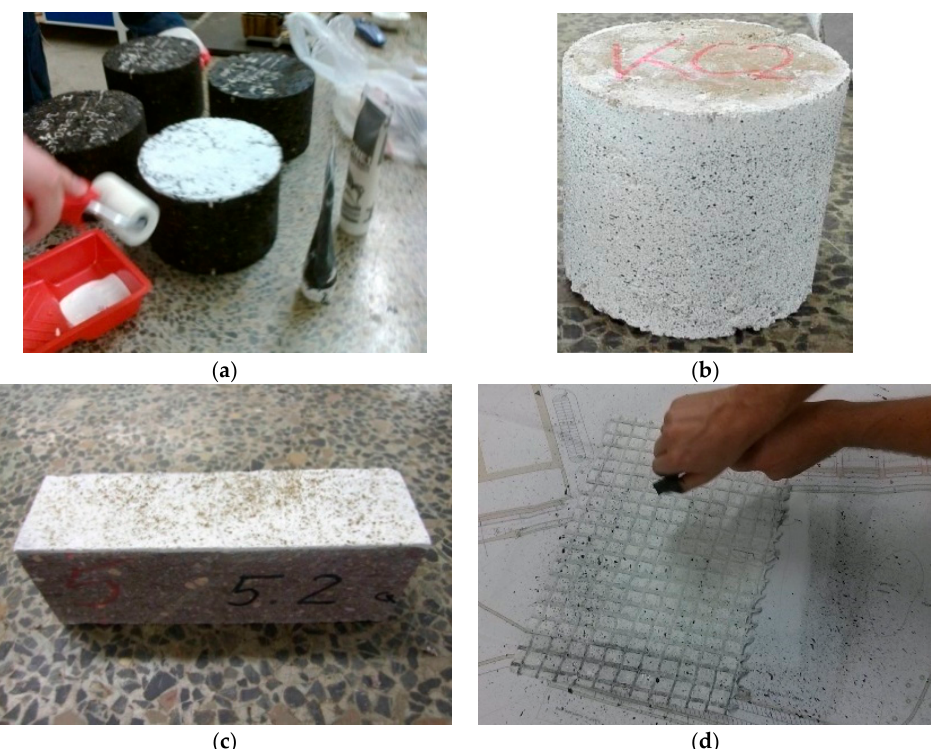
Figure 7. Preparation of the sample surface for testing with the DIC method: ( a ) Painting HMA (Hot-Mixed Asphalt) samples with white paint; ( b ) soil sample prepared to test; ( c ) Stone sample prepared to test—a white background sprinkled with pepper (so called “pepper method”); ( d ) spotting a geosynthetic sample with black colour.